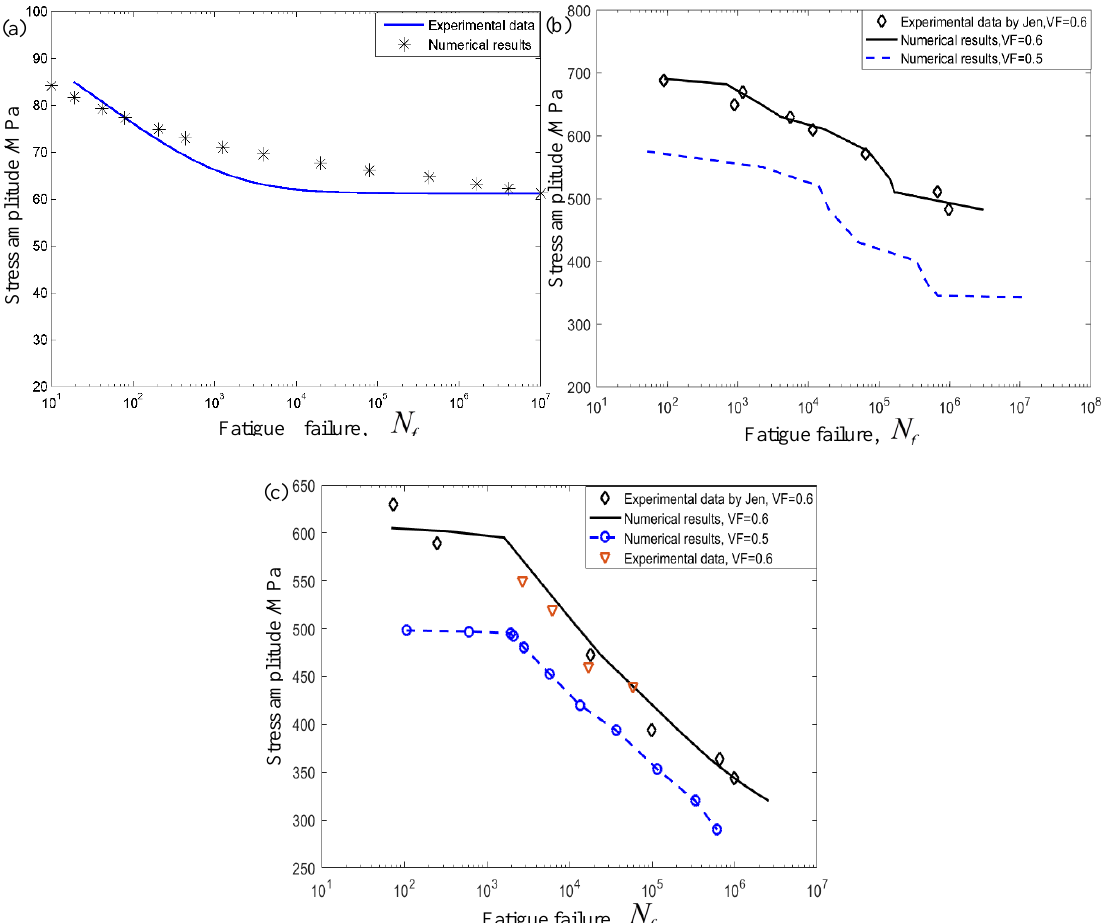
Figure 5. Comparisons of fatigue life at room temperature. ( a ) PEEK matrix at room temperature. ( b ) Composite laminates [ 0/45/90/ − 45 ] at room temperature. ( c ) Composite laminates [ 0/45/90/ − 45 ] at 100 °C.